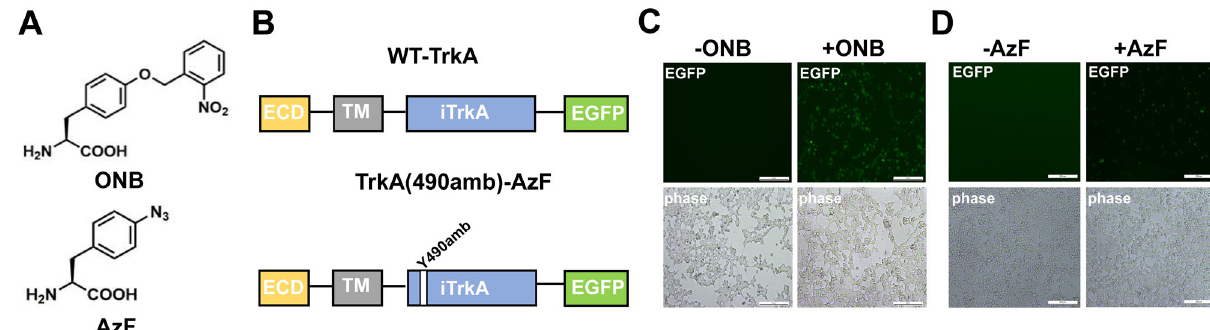
Fig. 1 The ONB and AzF incorporation in TrkA. a Structure of ONB and AzF. b Schematic diagram of the constructed TrkA receptor tagged with EGFP at the C-term. The full-length wt-TrkA receptor consists of an extracellular domain (ECD), a transmembrane domain (TM), an intracellular domain (iTrkA) and EGFP. TrkA(Y490amb) has an amber mutation (UAG) introduced into the Y490 position in the iTrkA domain. c , d Fluorescent images of live cells